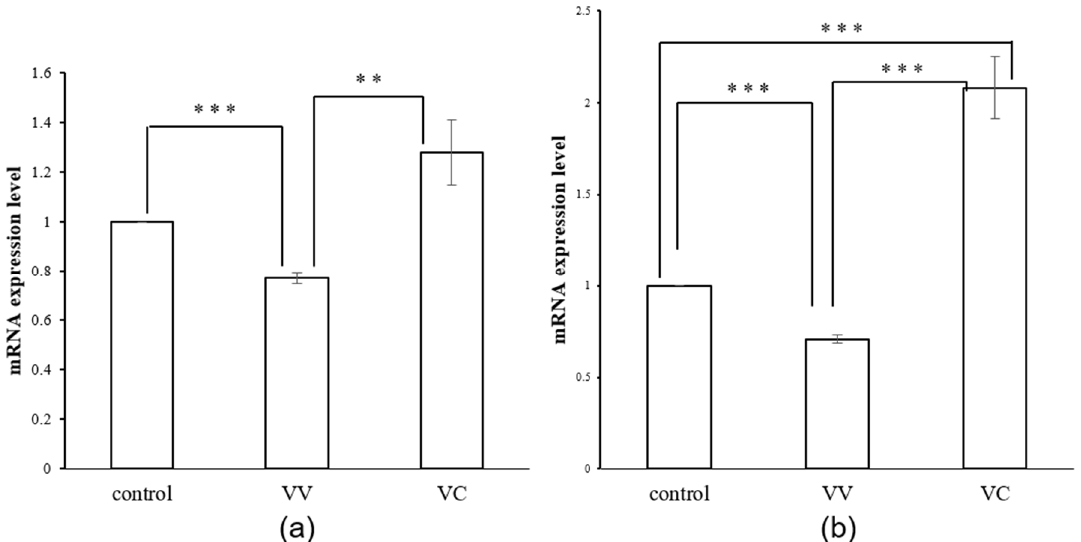
Figure 8. Levels of chloroplast ATP synthase mRNA in control, VIGS-vector, and VIGS-CtPPO C. terniflora leaves. ( a , b ) C. terniflora leaves at the ( a ) starting point and ( b ) after HUV-B+D treatment. Data are shown as mean ± SD of independent biological replicates. Asterisks indicate significant changes as measured by Student’s t -test (** p < 0.01, and *** p < 0.001).